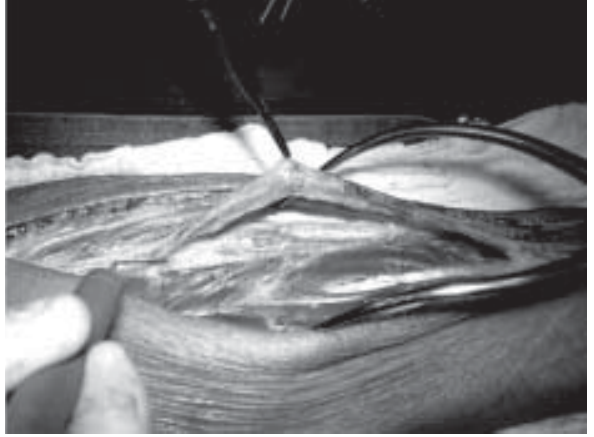
Fig. 5 – Dissection of the radial artery with